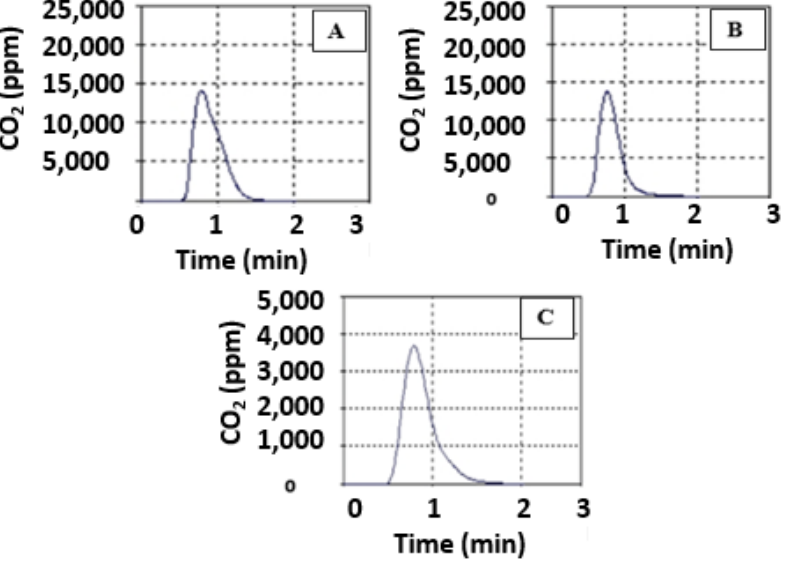
Figure 7. The plot of TOC vs. time for pectin and HAp/pectin composite; ( A ) = pectin, ( B ) = 90/10, and ( C ) = 50/50.